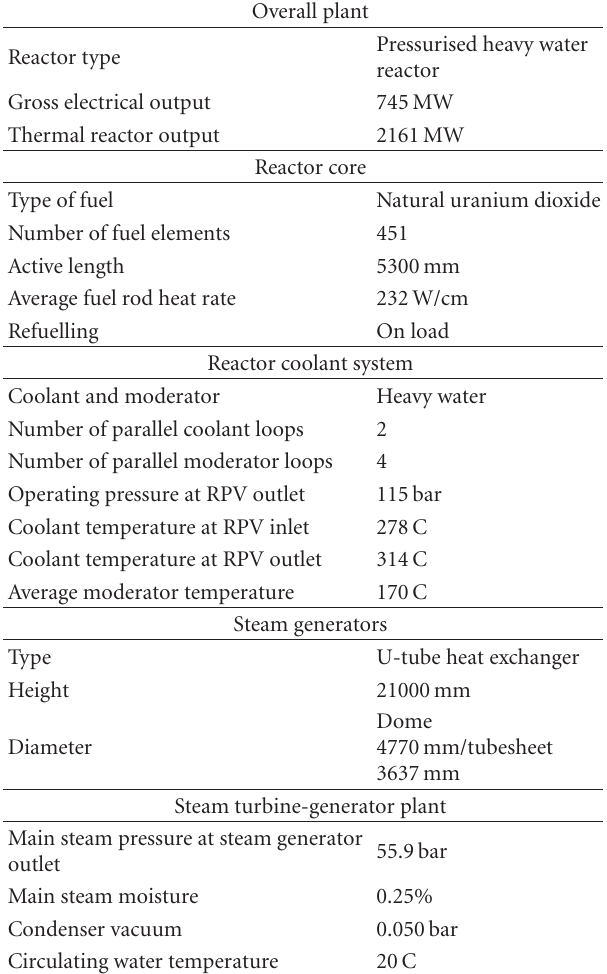
Table 1: General design parameters.